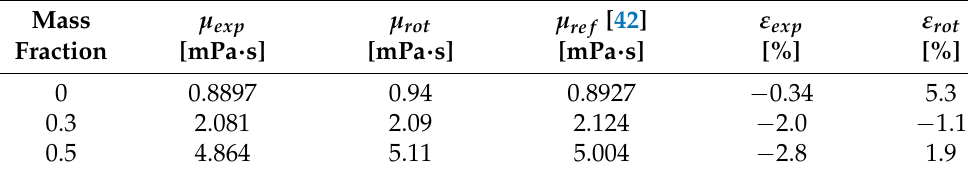
Table 3. Dynamic viscosity of water and aqueous solutions of